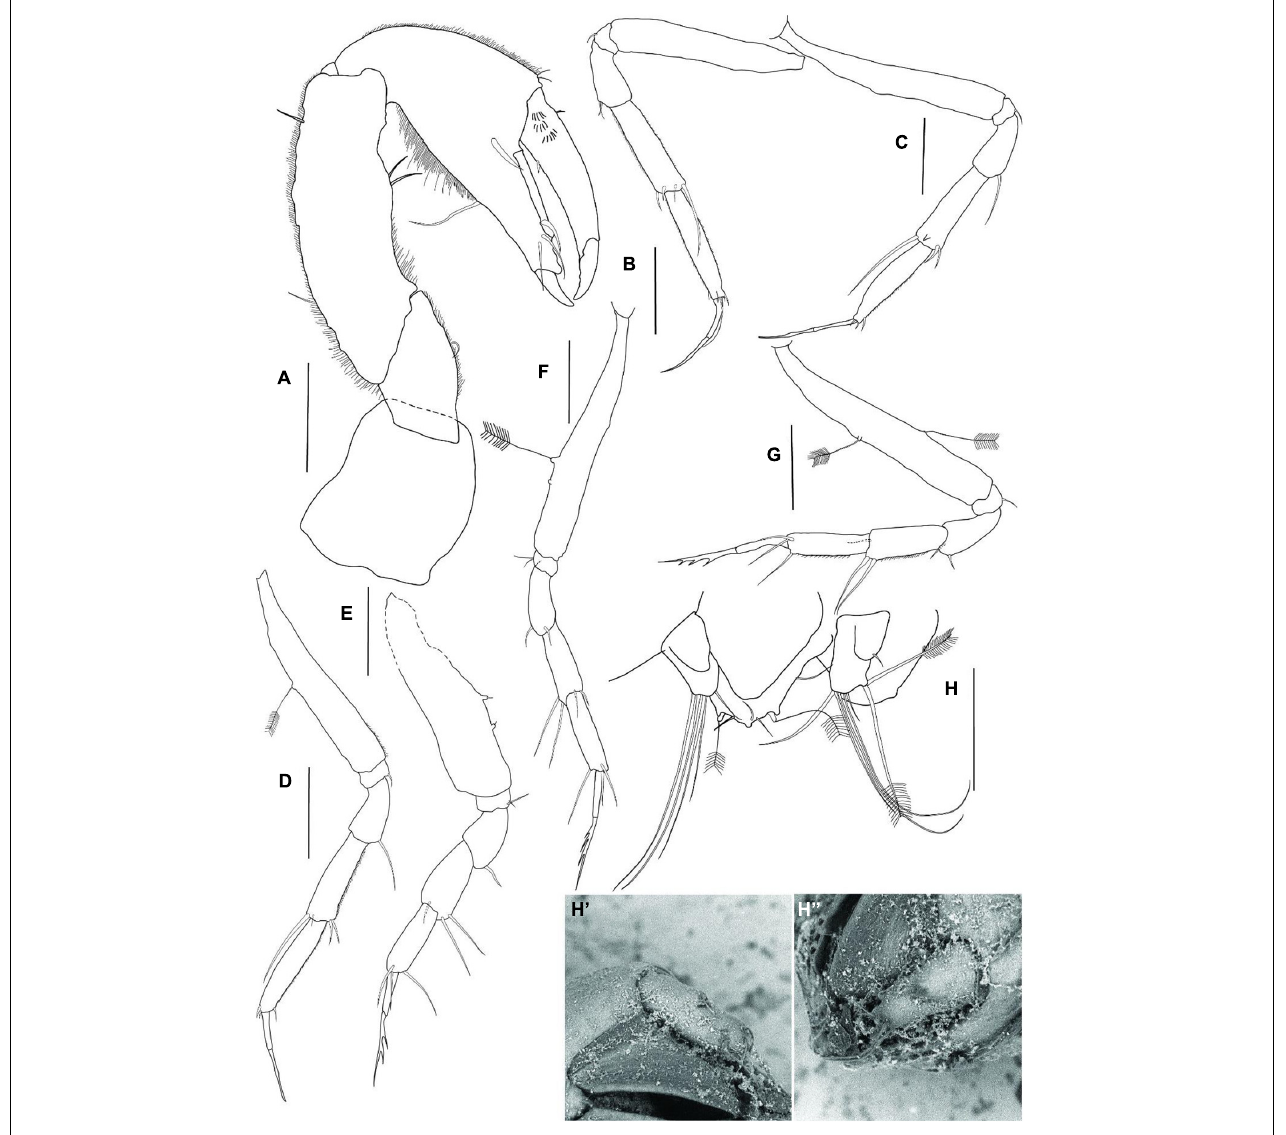
FIGURE 10 | Agathotanais jani n. sp., neuter, paratype (ZMH-K-61150). (A) cheliped; (B) pereopod-1; (C) pereopod-2; (D) pereopod-3; (E) pereopod-4; (F) pereopod-5; (G) pereopod-6; (H) uropod; (H’) detail of uropod – ventral view (SEM picture); (H”) detail of uropod – lateral view (SEM picture). Scale bar: (A–D) = 100 µ